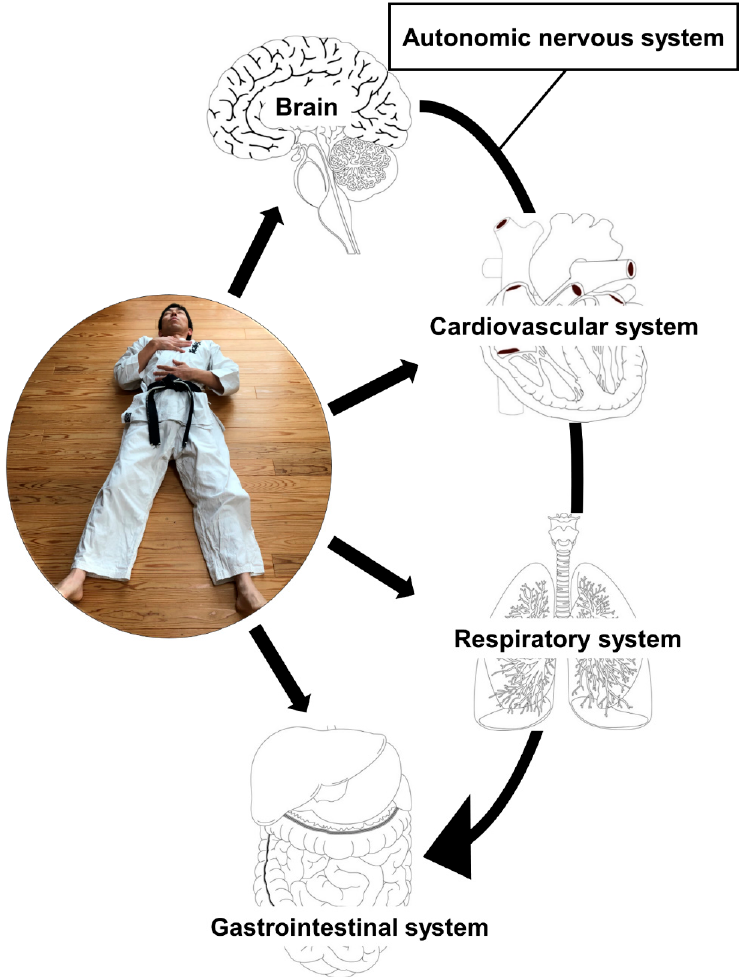
Figure 1. Breathing in slowly and deeply through the nose with a minimum movement of the chest in a supine position with one hand placed on the chest and the other on the belly. Diaphragmatic breathing has an impact on the brain and cardiovascular, respiratory, and gastrointestinal systems through the modulation of the autonomic nervous function.